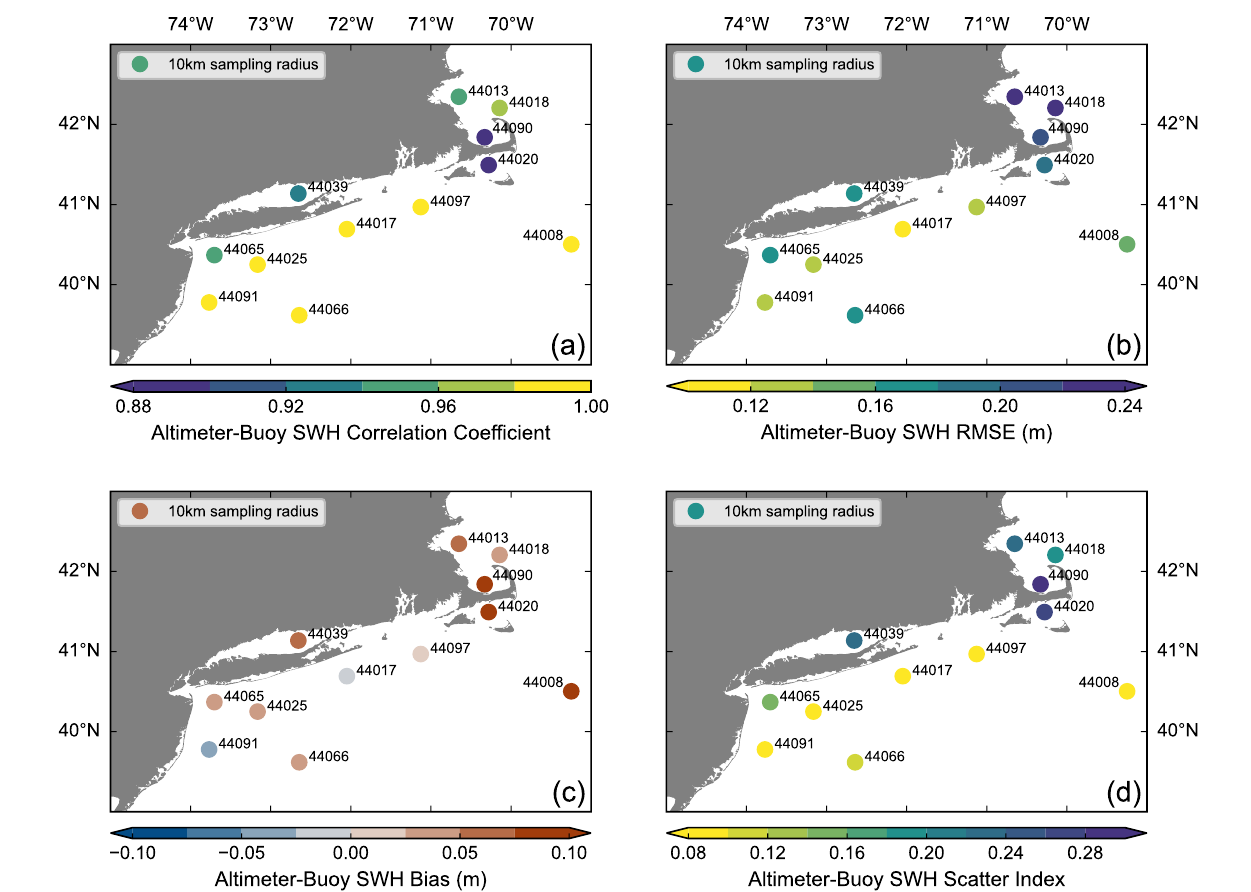
Figure 6. SWH validation metrics of the collective altimeter dataset against the collocated buoy observations at each station. Pearson’s correlation coefficient ( a ), RMSE ( b ), Bias ( c ), and SI ( d ) maps visualize the comparison spatially in the